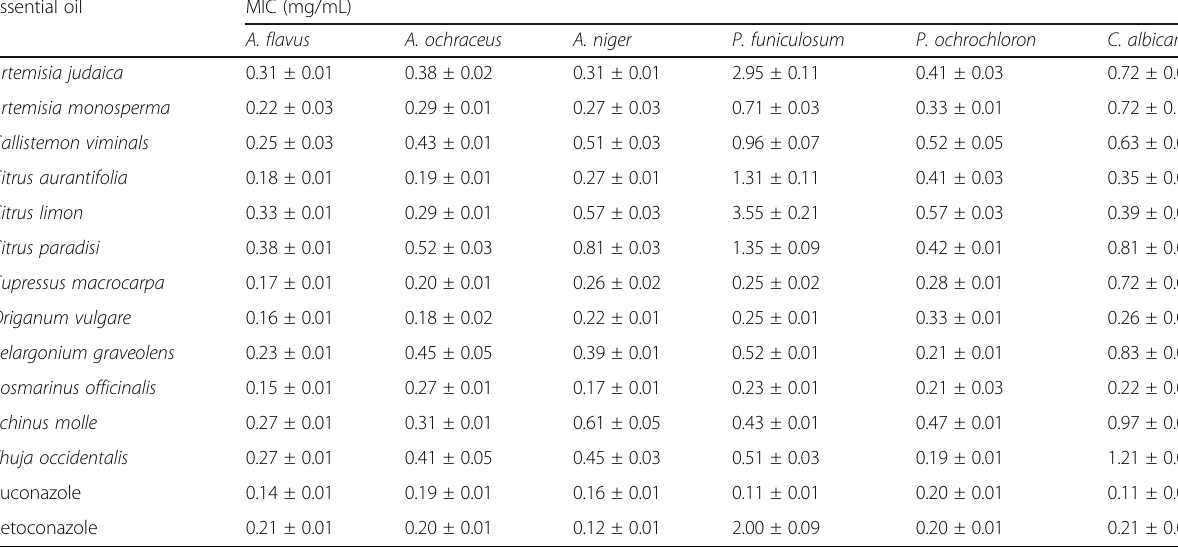
Table 3 Minimum inhibitory concentration (MIC) of essential oils on fungal strains Essential